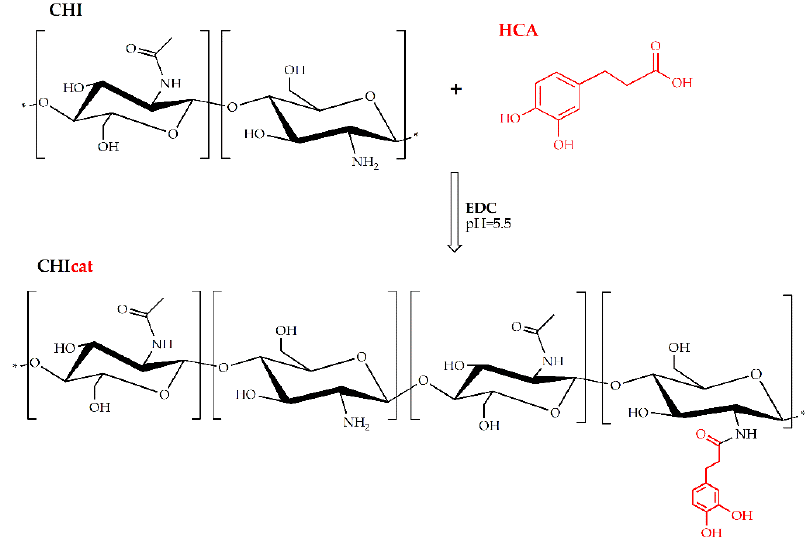
Figure A7. EDS spectra of the polymeric films (CTR100, CTR50, and Cat50) after SBF immersion for 14 days at 37 °C.